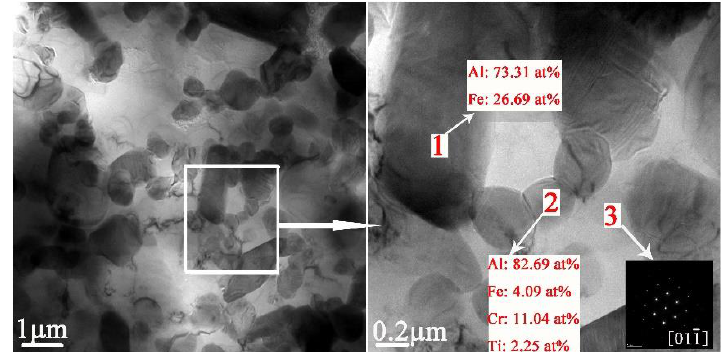
Figure 12. TEM/BF micrograph of sintered sample with compaction velocity 9.4 ms − 1 : bright field images for intermetallic compound.